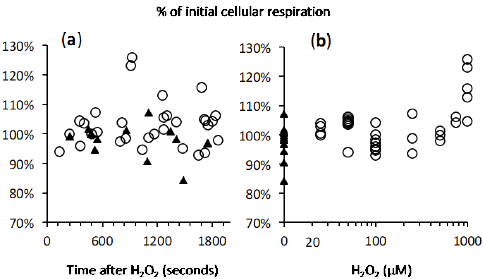
Figure 7. Absence of impact of H 2 O 2 on CHO cells respiration. Y axis = cellular oxygen consumption after H 2 O 2 had been exhausted and expressed as percent of the initial rate (rate recorded just before H 2 O 2 addition). ( a ) X axis = lag time between H 2 O 2 addition and measurement oxygen consumption rate; black triangles refer to concomitant control experiments (without H 2 O 2 ). ( b ) X axis = amount of H 2 O 2 injected in the experiments represented in panel a.